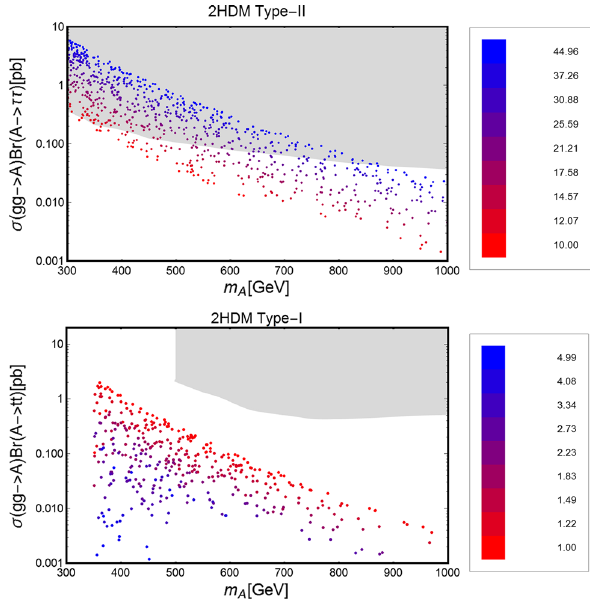
Fig. 15 Upperpanel pp → ¯ ττ crosssectionfortype-II2HDM. Lower panel pp → ¯ tt for 2HDM type-I realizations in the low tan β regime. In both plots the points follow a color code according to the value of tan β . The gray regions are already experimentally